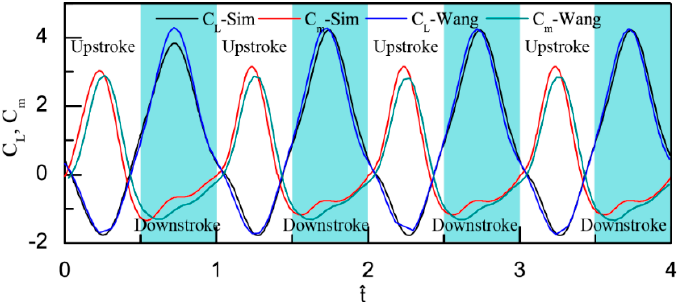
Figure 9. Comparison in lift coefficients and rotational moment coefficients between CFD calculation by fluent software and computational results by Wang et al.